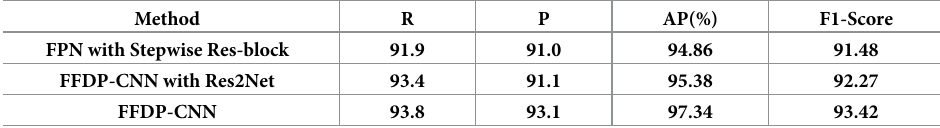
Table 8. Comparison between proposed framework and other methods on